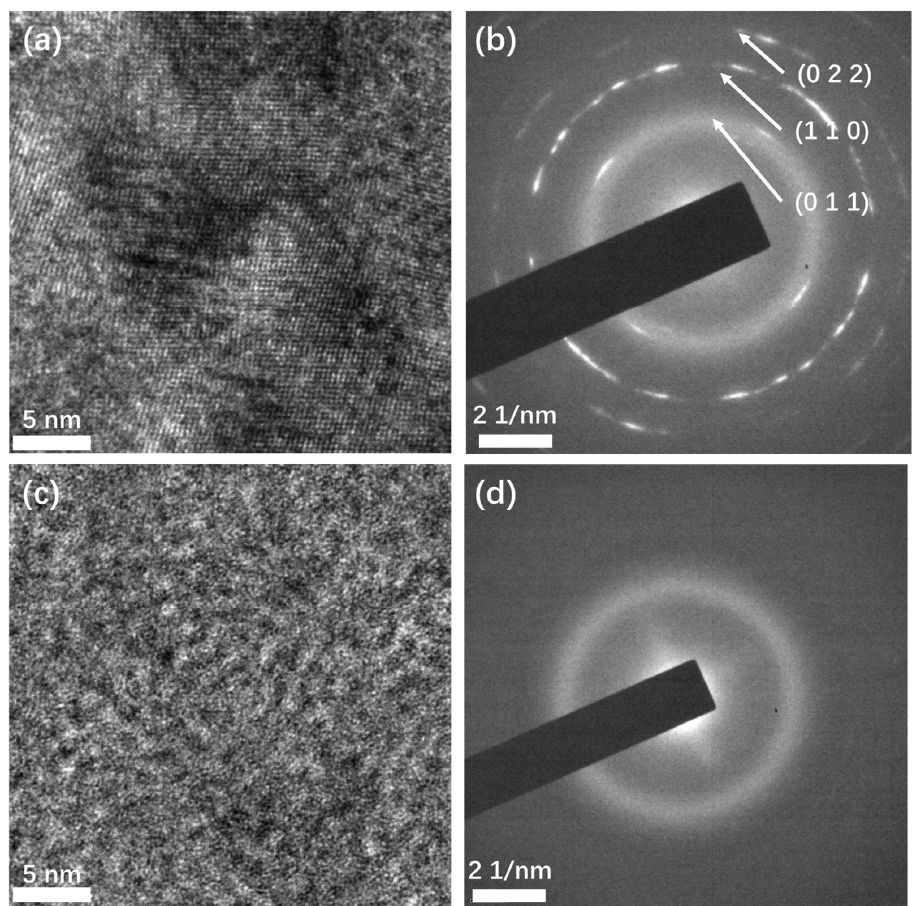
Figure 3. TEM characterization of the Sb films deposited at different temperatures. ( a ) HRTEM im ‐ age and ( b ) SAED image of Sb film deposited at high temperature; ( c ) HRTEM and ( d ) SAED image of Sb film deposited at room temperature.